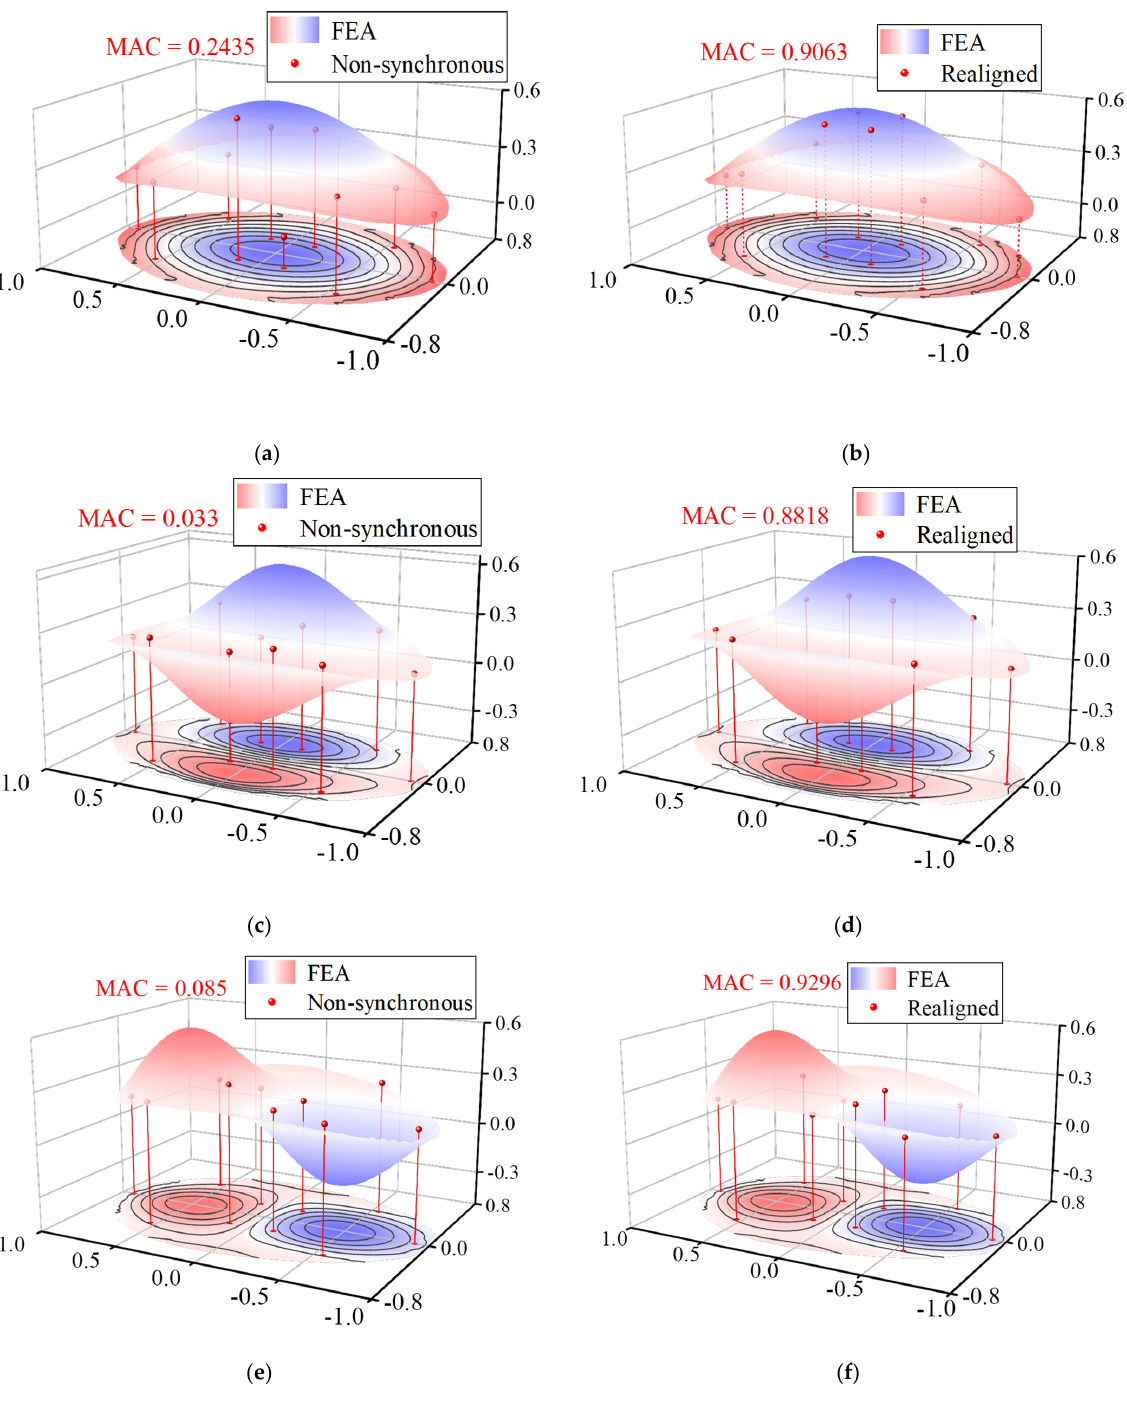
Figure 19. Mode shapes of the first 3 modes of NSSO identified from aligned acceleration and realigned acceleration: ( a ) 1st mode-aligned, ( b ) 1st mode-realigned, ( c ) 2nd mode-aligned, ( d ) 2nd mode-realigned, ( e ) 3rd mode- aligned, and ( f ) 3rd mode-realigned.